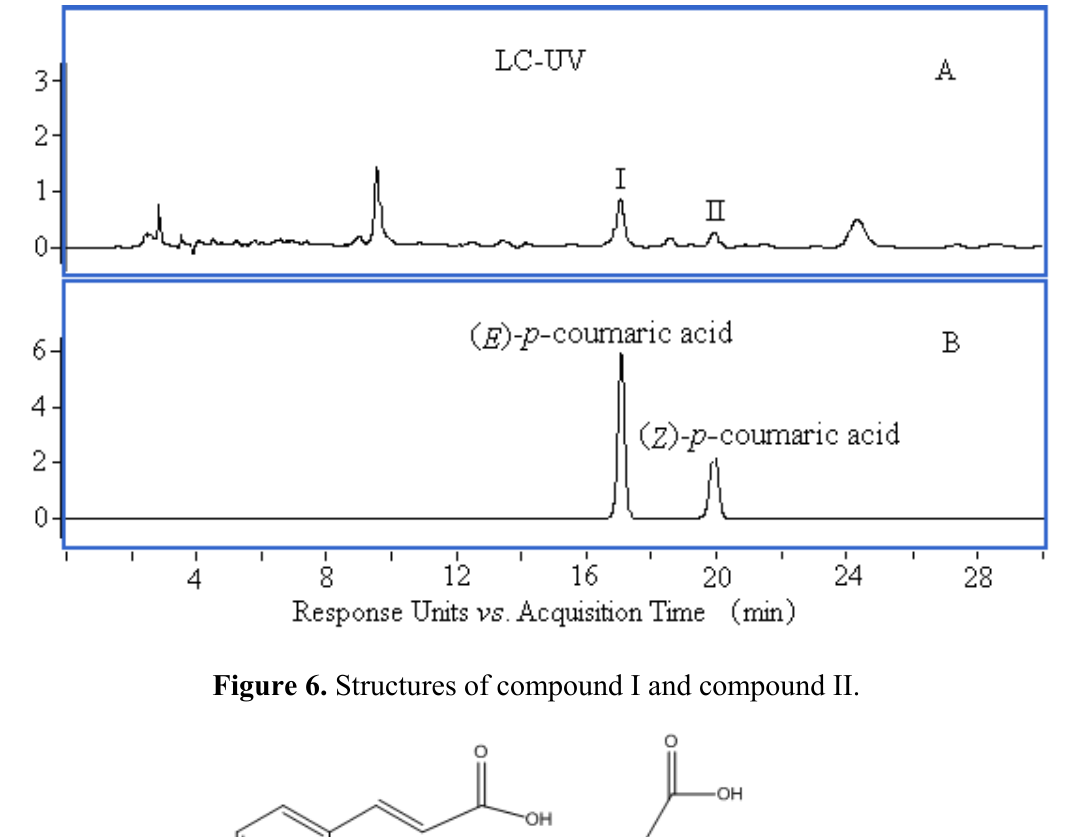
Figure 5. HPLC chromatograms of plasma sample ( A ) and p -coumaric acid standards ( B ).